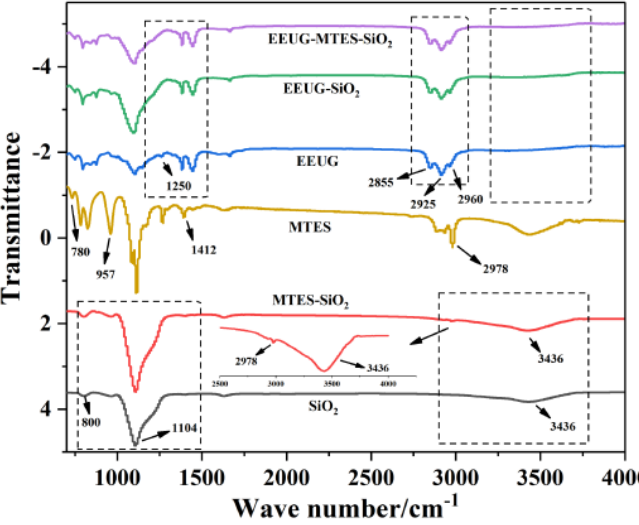
Figure 2. FTIR spectra of EEUG, MTES, SiO 2 , and modified SiO 2 .